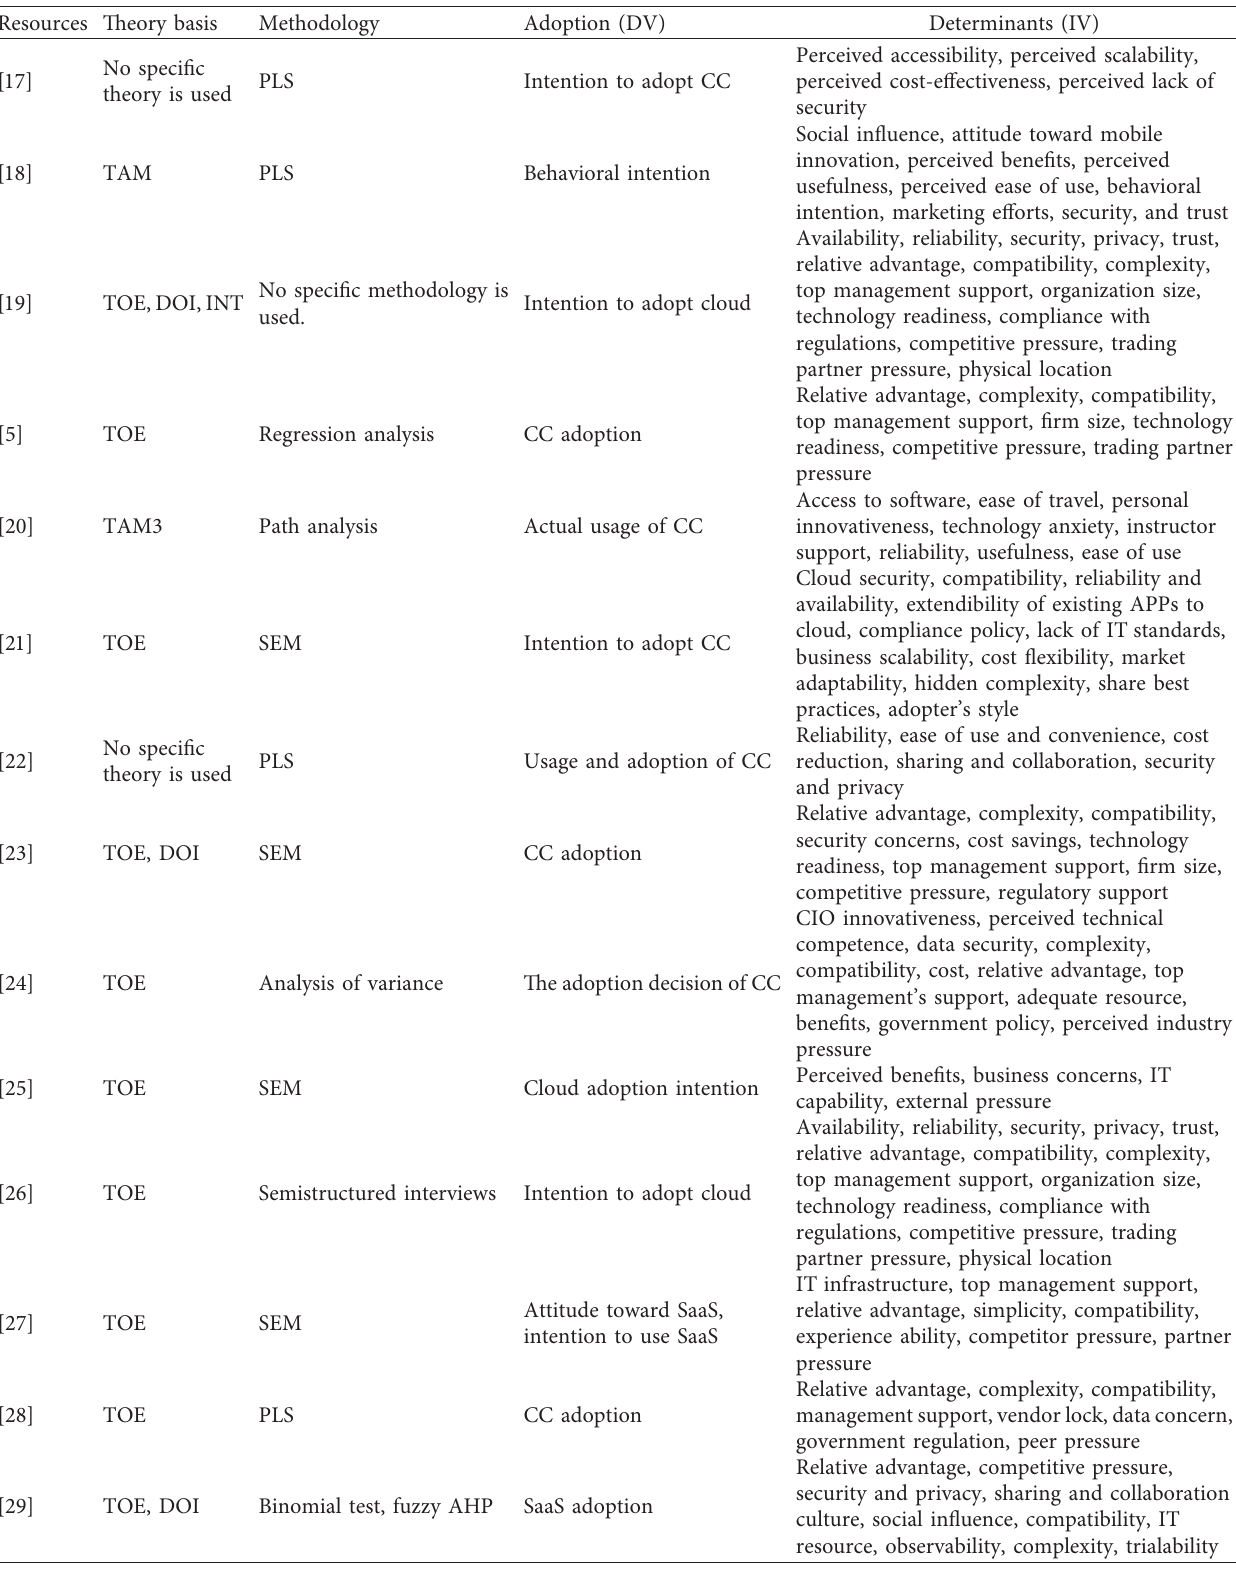
Table 1: Empirical research on cloud service